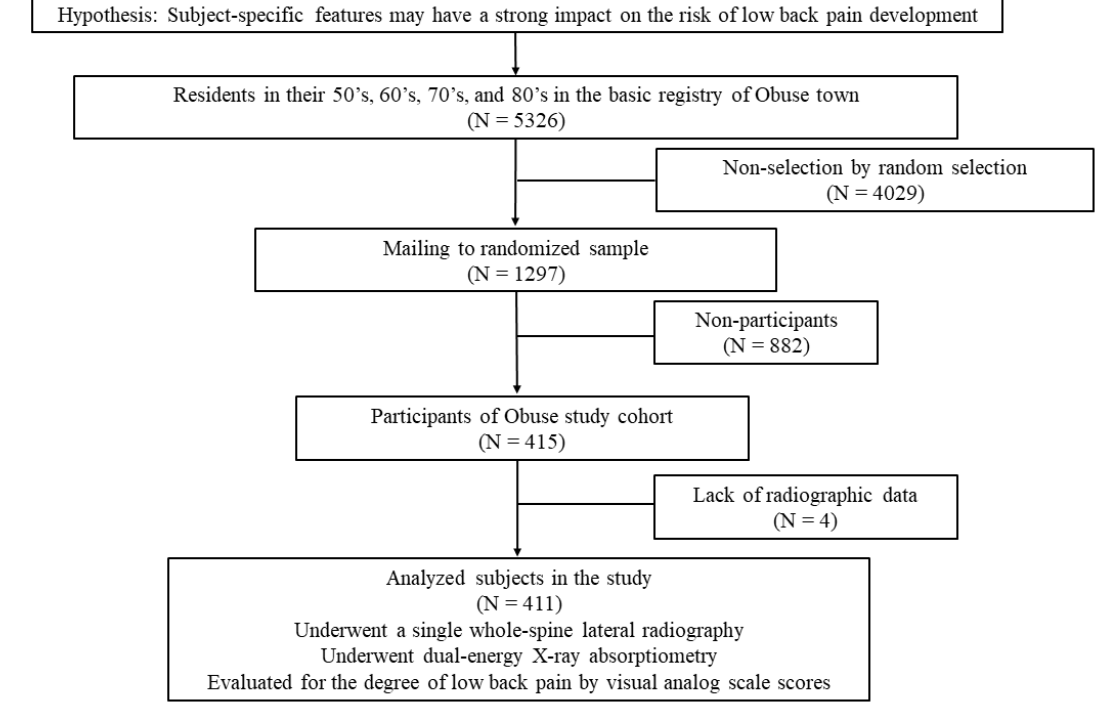
Figure 1. Obuse town resident participant flowchart. Table 1. Baseline